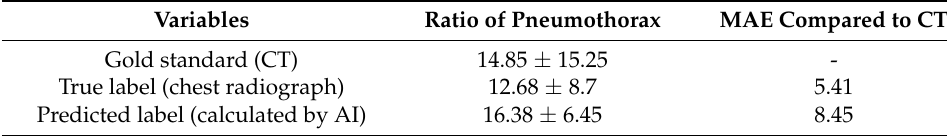
Table 3. Amount of pneumothorax calculated by humans and AI.